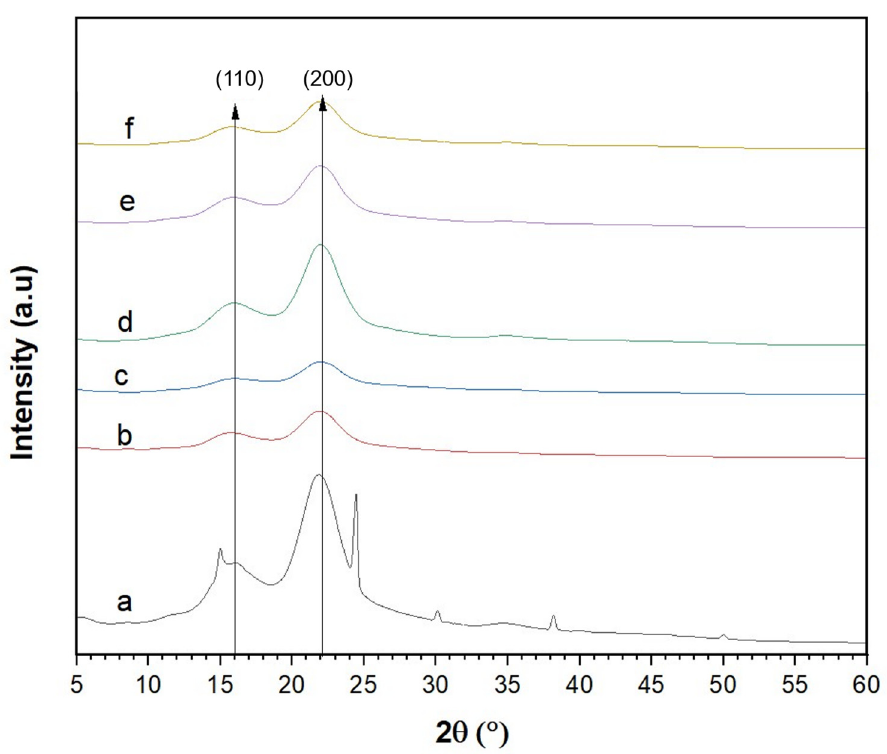
Figure 6. X-ray diffraction pattern of the nanocellulose obtained after hydrolysis with different sulfuric acid concentrations: ( a ) 0%, ( b ) 2%, ( c ) 4%, ( d ) 6%, ( e ) 8%, and ( f ) 10%.